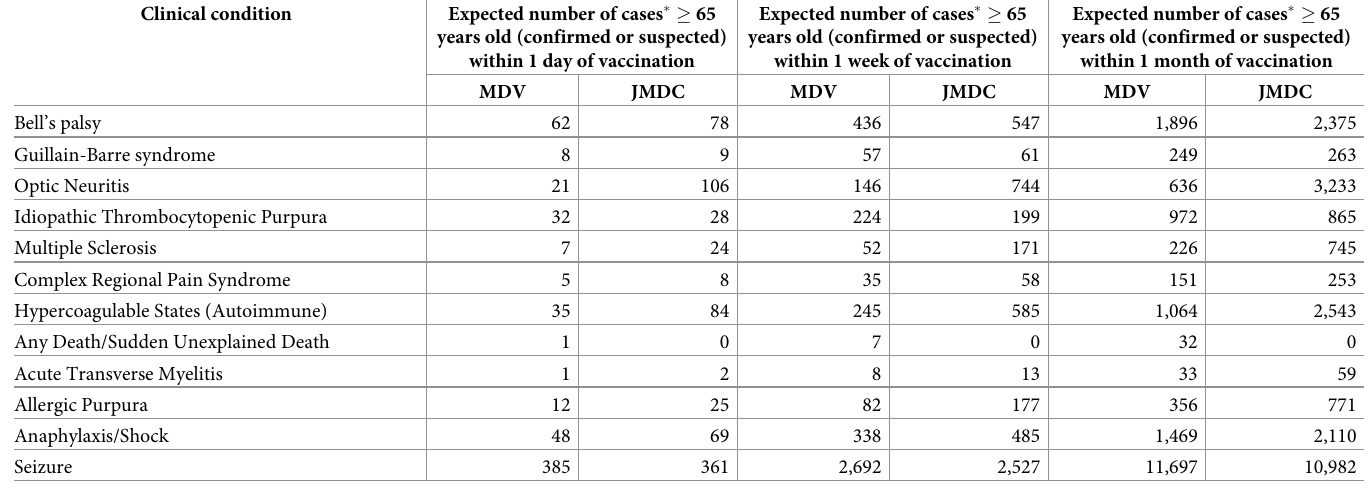
Table 17. Expected number of cases for various clinical conditions within different time periods of vaccination for those 65 years and older based on data from the MDV and JMDC databases. Clinical